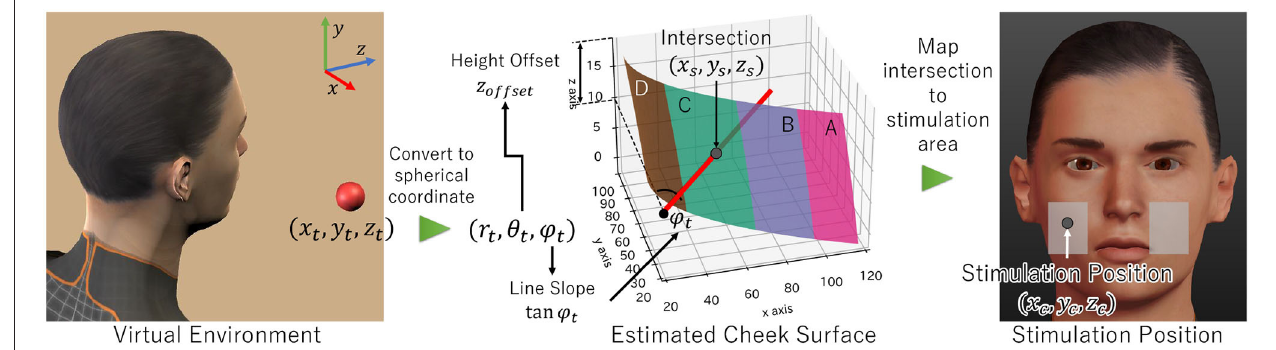
FIGURE 5 | Haptic stimulation flow. The target position was converted to an azimuthal and an elevational angle. These two angles were translated into a line. The intersection between the line and the cheek surface was calculated and was mapped to the stimulation area (the transparent gray area) to obtain the stimulation